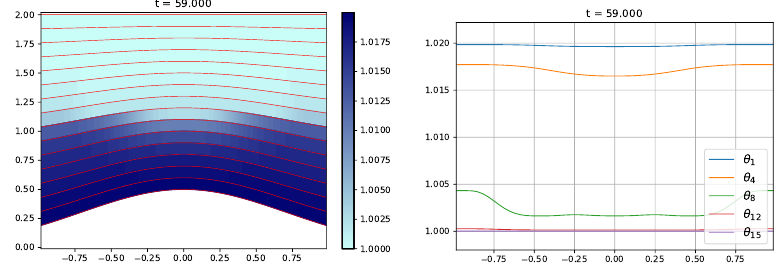
Figure 38. Distribution of θ for a cut in the plane y = 0 (upper row) and x = − 2 (lower row).